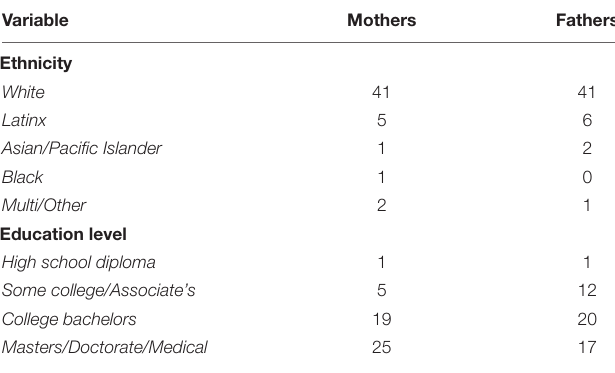
TABLE 1 | Demographic backgrounds of mothers and